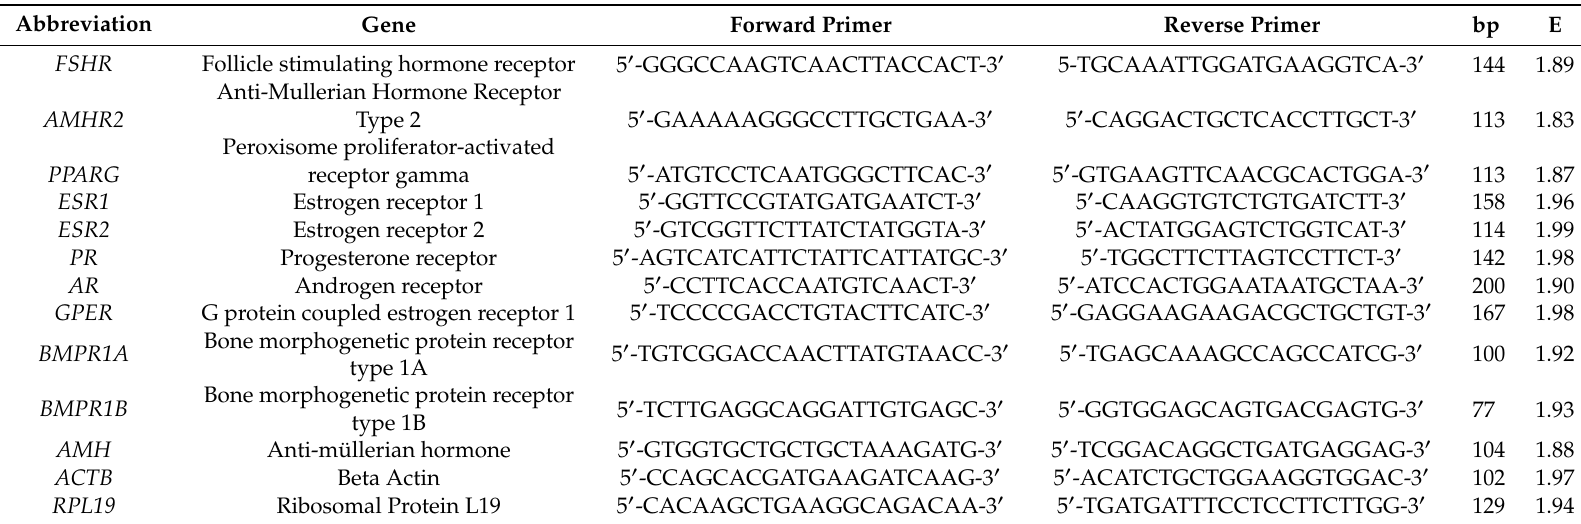
Table 3. Primer sequences used for the qRT-PCR